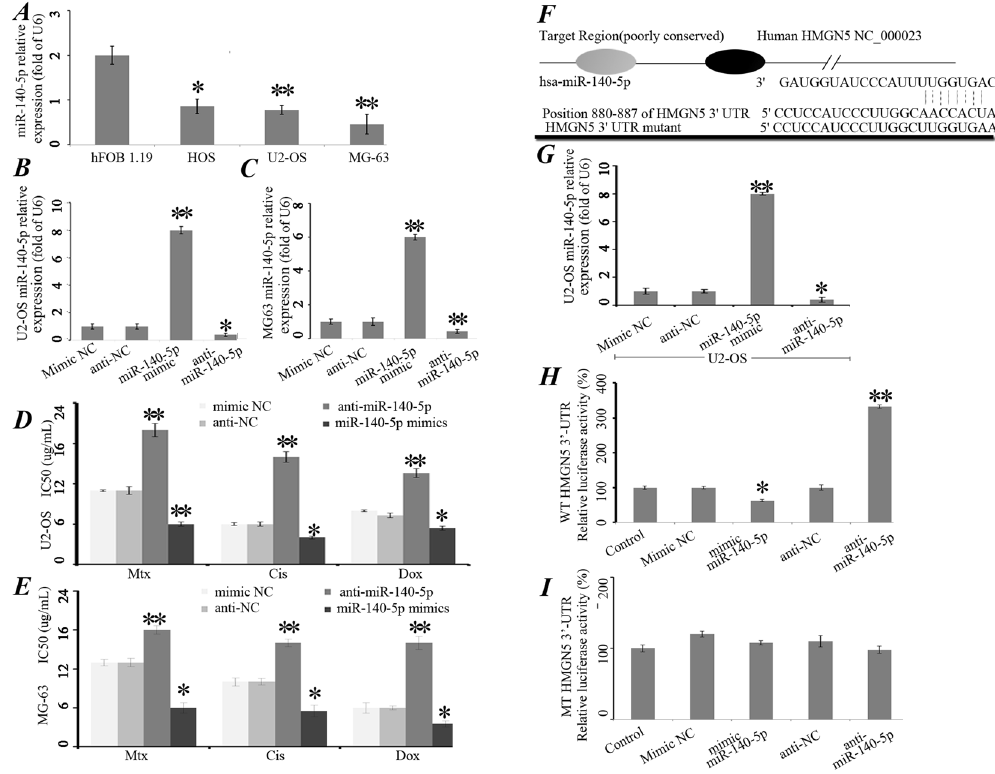
Figure 2. miR-140-5p regulated the sensitivity of osteosarcoma cells to chemotherapeutic agents in vitro by targeting HMGN5. ( A ) Endogenous expression levels of miR-140-5p in the human osteoblastic cell line, hFOB 1.19, and three osteosarcoma cell lines were determined by qRT-PCR and normalized to those of U6 snRNA. Each bar represents the mean of 3 independent experiments. * P < 0.05, ** P < 0.01. Expression of miR-140-5p was detected by qRT-PCR after transfected with mimic NC, miR-140-5p mimics (50 NM), anti-NC or anti- miR-140-5p (100 NM) in U2-OS ( B ) and MG-63 ( C ) cells. miR-140-5p up-regulated the chemoresistence of osteosarcoma cells to chemotherapeutic agents in U2-OS ( D ) and MG-63 ( E ) cells in vitro . ( F ) The target genes of miR-140-5p were predicted using bioinformatic analysis. ( G ) Expression of miR-140-5p was detected by qRT-PCR after transfection of U2-OS cells with mimic NC, miR-140-5p mimics, anti-NC or anti-miR-140-5p. ( H ) Dual luciferase assays were performed in U2-OS cells after cotransfection with HMGN5 3 ′ -UTR plasmids and anti-miR-140-5p or miR-140-5p mimics. ( I ) Luciferase construct containing mutant target site of the HMGN5 3 ′ -UTR was generated and transfected as indicated. * P < 0.05, ** P <